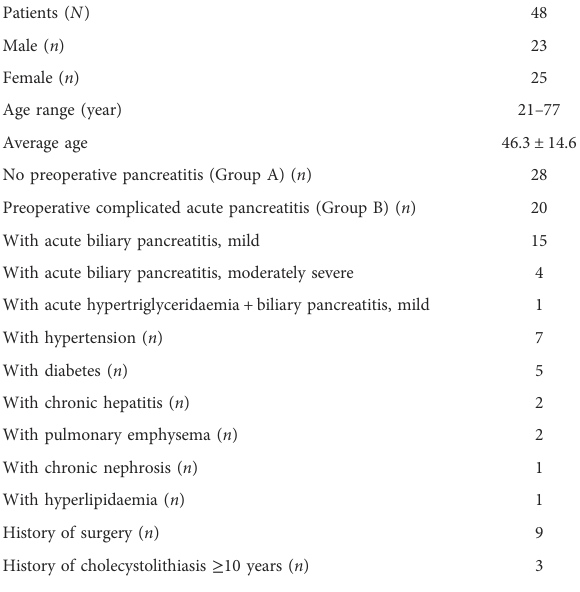
TABLE 2 Characteristics of